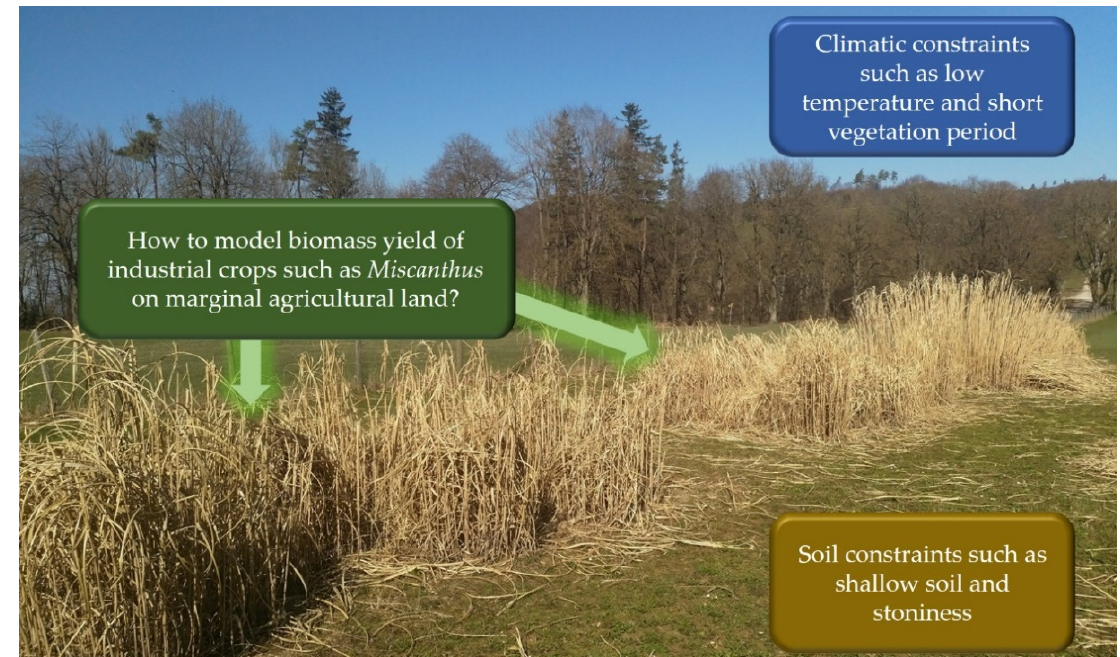
Figure 1. Schematic overview of the subject of this study using the example of the cultivation of different Miscanthus Andersson genotypes whose performance has been tested on a shallow stony soil in southwestern Germany since 2014. Clear differences in aboveground biomass growth can be seen here (photograph was taken in winter 2019–2020). These result not only from climatic and soil physical site influences but also from the physiological and morphological characteristics of the